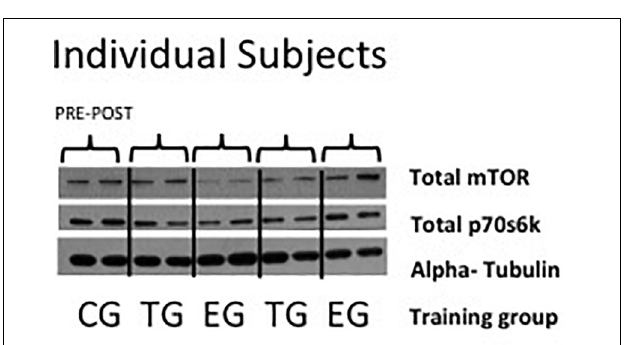
FIGURE 2 | Representative picture of Western blots of individual subjects of total mTor, total p70s6k, and alpha-tubulin in EMS-Group (EG), Training-Group (TG), and Control-Group (CG) measured 2 weeks before (Pre) and after the intervention period (Post).